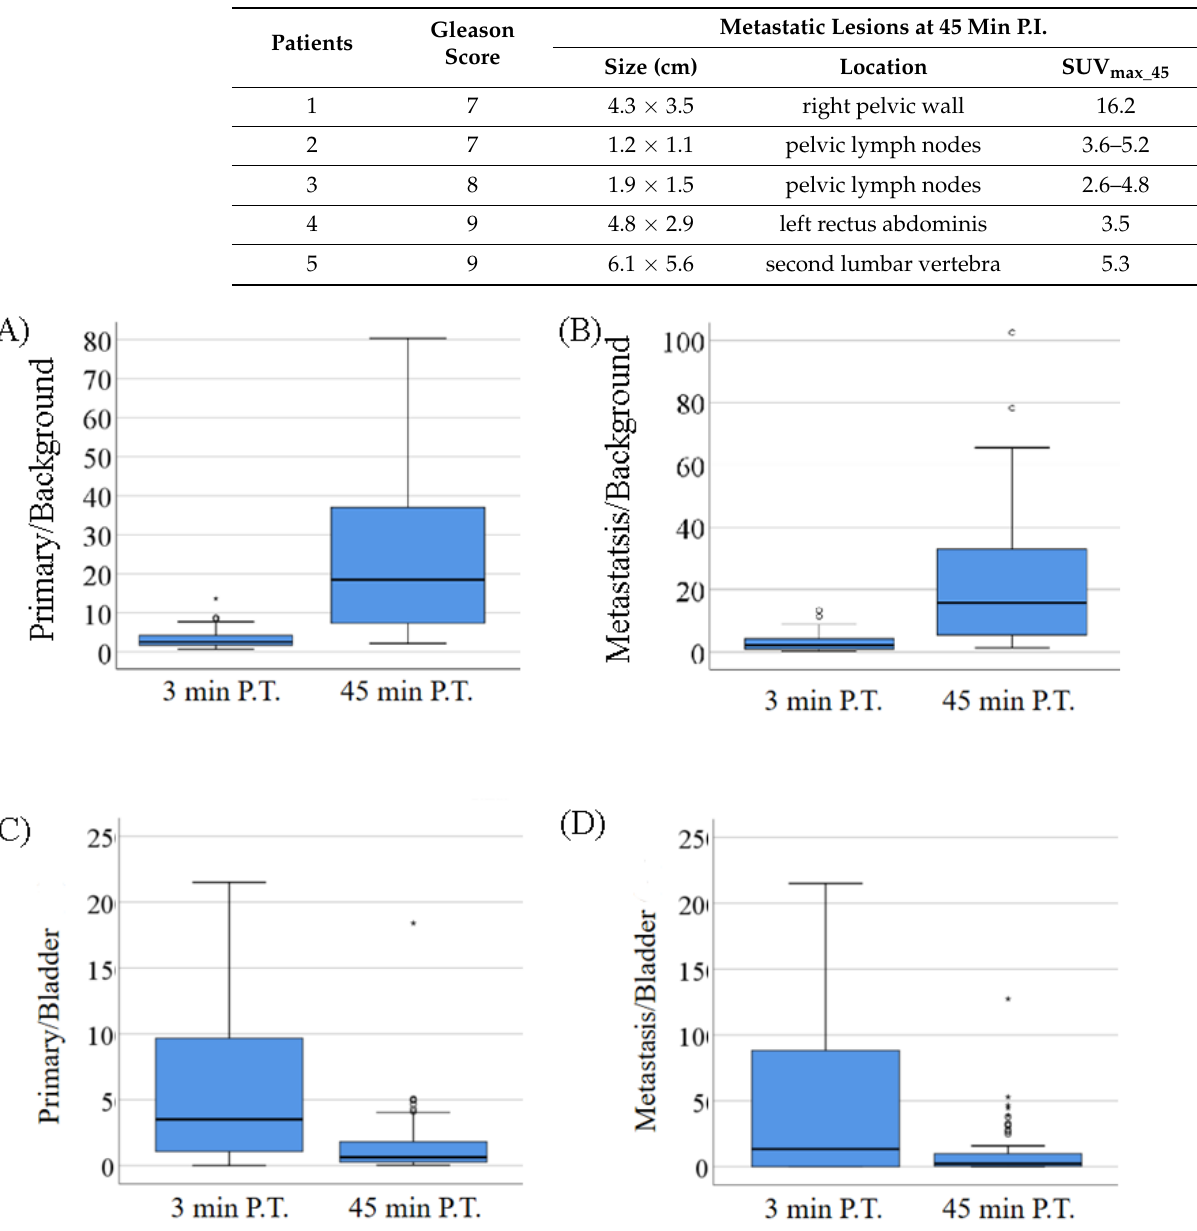
Figure 4. 68 Ga-PSMA-11 PET/CT in a 65-year-old PCa patient after endocrine therapy with elevated tPSA (42.18 ng/mL). ( A ) Focal increased 68 Ga-PSMA-11 uptake (SUV max = 22.7, T/BL ratio = 15.1) on the posterior wall of the bladder on fused axial PET/CT at 3 min P.I. (white arrow). ( B ) Correspond- ing bladder images at 45 min P.I., with markedly increased tracer accumulation. Differentiation of lesions and physiologic urethra activity was not possible. Besides lymphatic metastasis, pelvic osseous metastases were also commonly de- tected in patients with advanced prostate cancer. A super early PSMA PET scan can also provide important information on osseous metastases. As shown in Figure 5, multiple bone metastases were observed in a 78-year-old PCa patient after endocrine therapy (tPSA